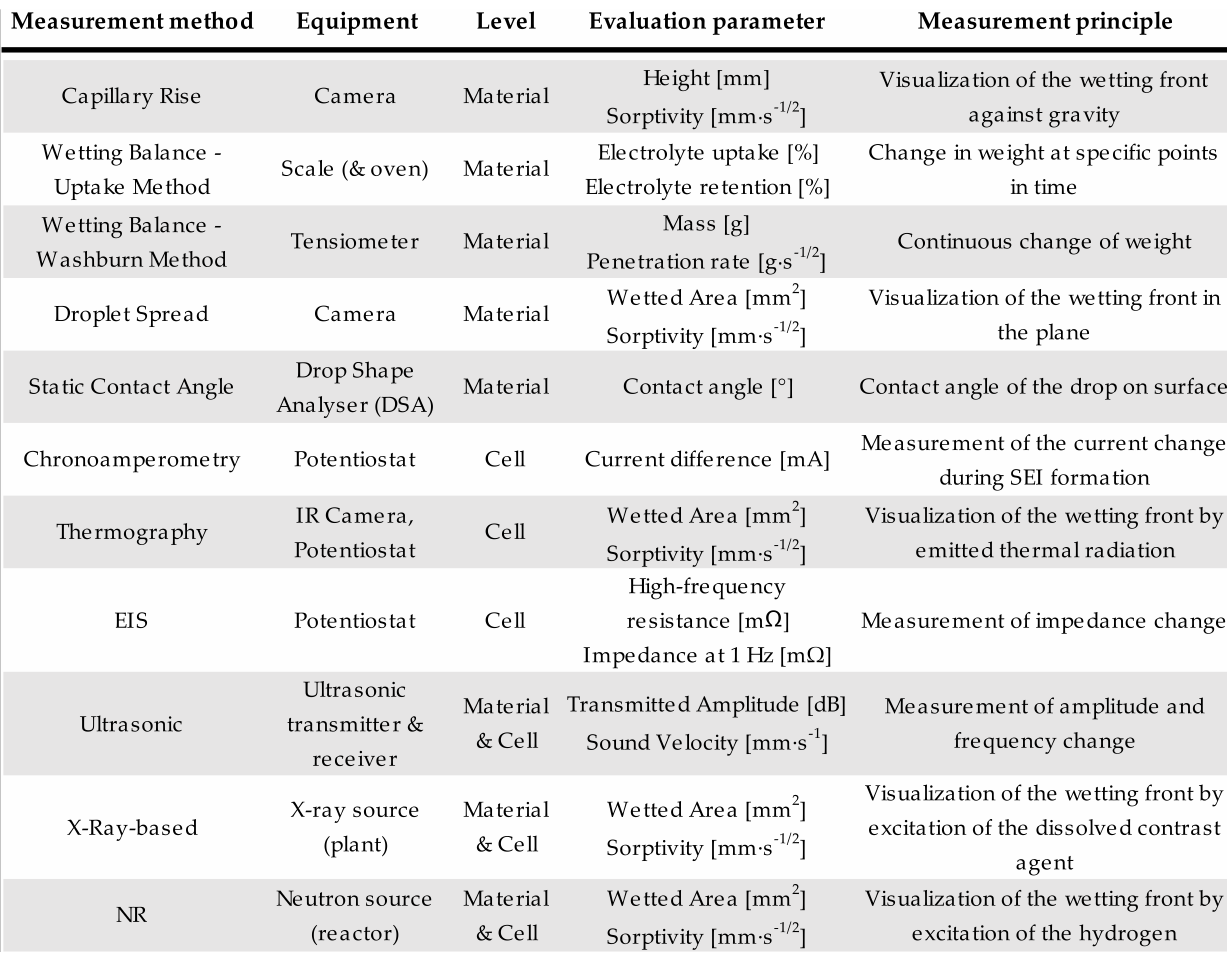
Table 4. Overview of the measurement methods used to determine wetting